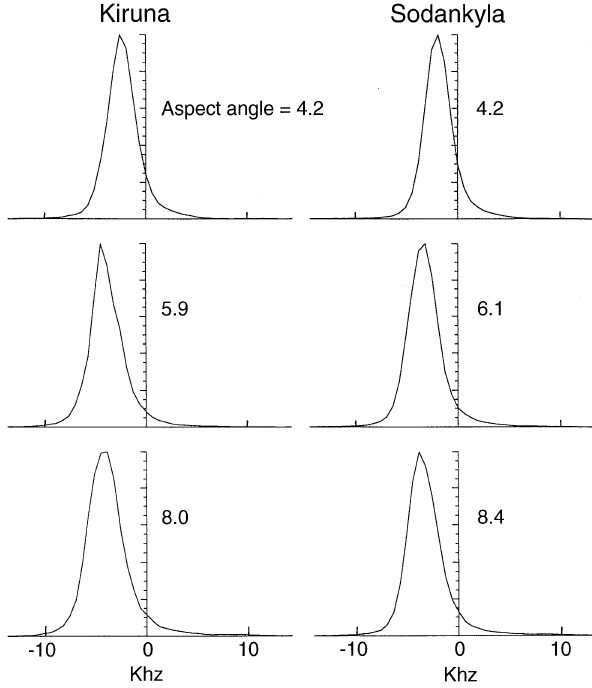
Fig. 4. Examples of coherent spectra observed at Kiruna and Sodankyla¨ , for transmitter elevations of 10 ° , 14 ° and 18